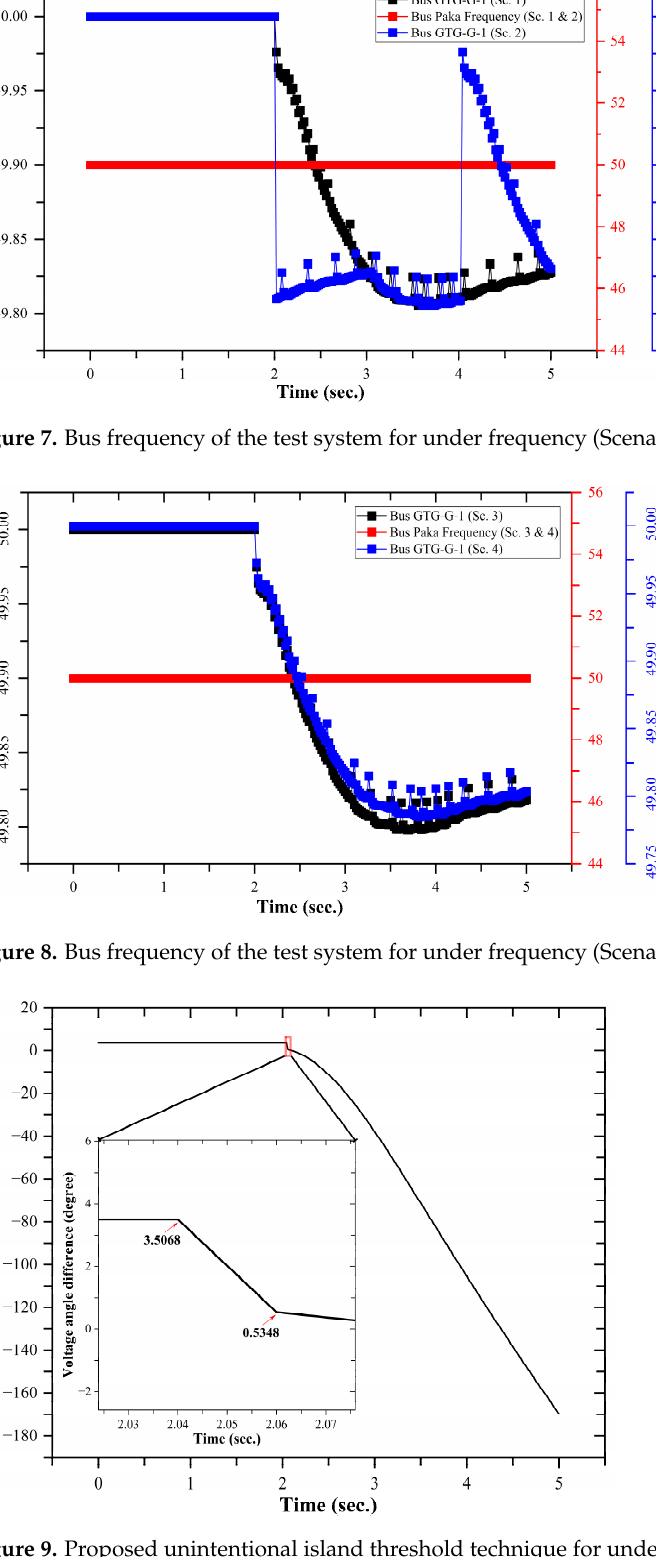
Figure 10. Proposed unintentional island threshold technique for under frequency Scenario 2.